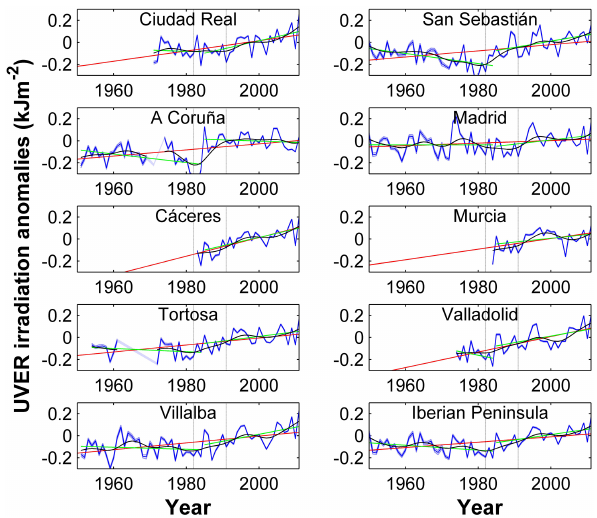
Figure 4. Evolution of the annual UVER irradiation anomalies and their uncertainties for ten series. The red line corresponds to a lin- ear fit between 1950 and 2011, and green lines to linear fits in the 1950–1984 and 1985–2011 periods. The solid black line is a 21-year Gaussian low-pass filter, and the years 1982 and 1991 are marked with a dashed black